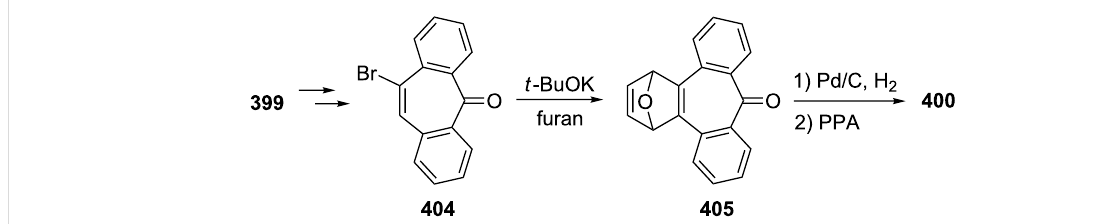
Scheme 75: Synthesis of tribenzotropone ( 400 ) from dibenzotropone 399